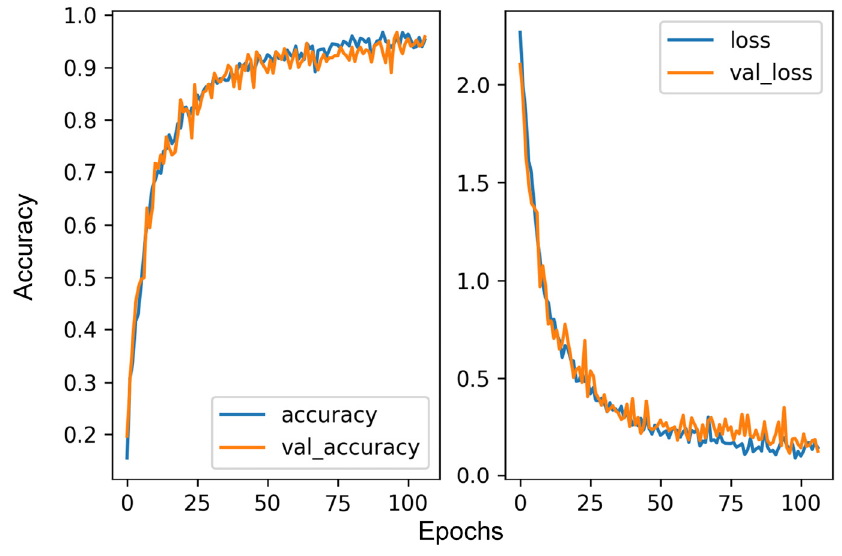
Figure 9. Learning curves of the custom model (Model 4).